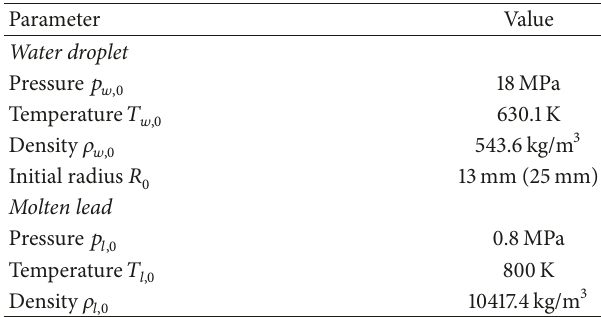
Table 1: Parameters of numerical simulation of single-drop water- lead